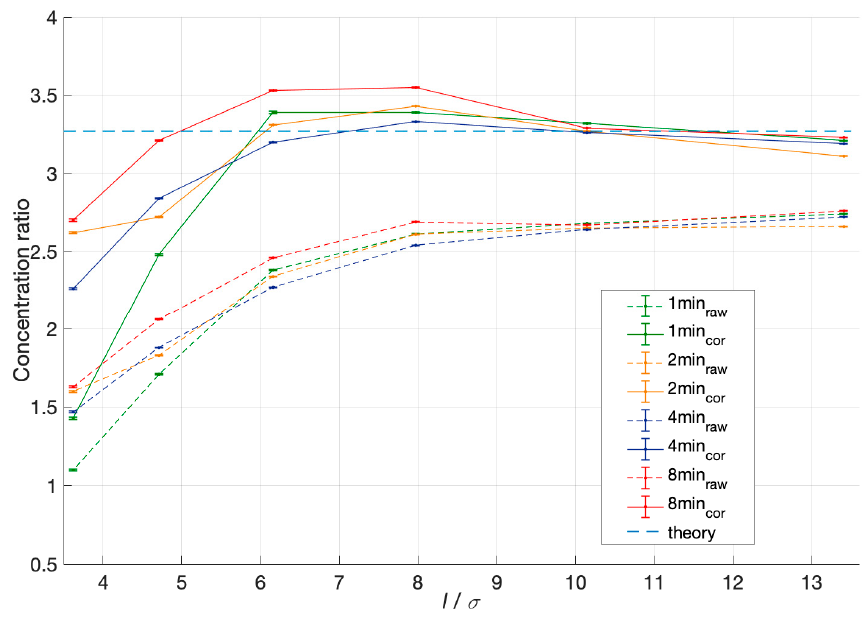
Figure 3. Comparison between the concentration ratio for the raw image (dotted lines) and the PVE corrected image (continuous line) at different acquisition times, shown with different colors.